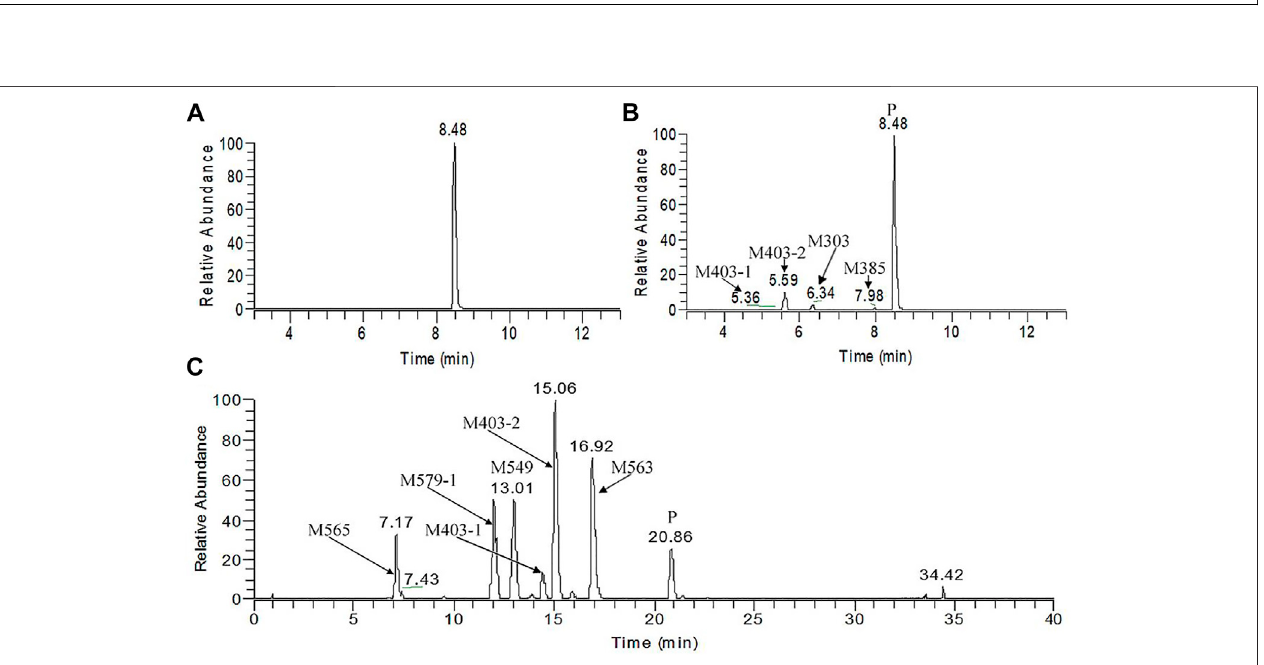
Frontiers in Pharmacology |